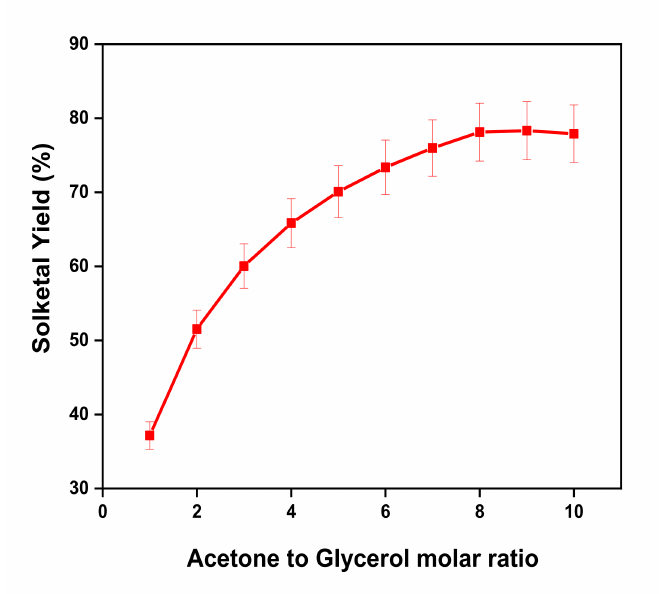
Figure 4. Influence of acetone to glycerol molar ratio on solketal